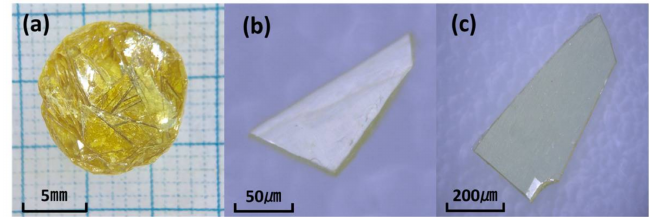
Figure 3. ( a ) The obtained crystalline mass; ( b ) A 120 × 80 × 20 µ m 3 crystal stripped from crystalline mass; ( c ) A 340 × 210 × 40 µ m 3 crystal consisting of two domains superimposed along the c